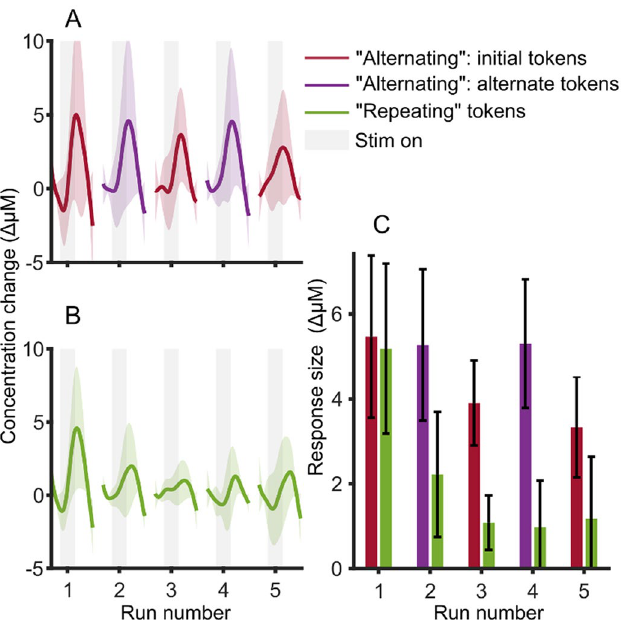
Figure 9. Comparison of responses to two sound presentation strategies. ( A ) Shows the “alternating” protocol, where two speech token pairs are presented in alternating runs. ( B ) Shows the “repeating” protocol, where the same speech token pair was repeated in five sequential runs. Shaded error bars show one standard deviation across participants. ( C ) Shows the calculated response sizes for both protocols as bar plots, with error bars showing one standard error of the mean; test statistics were calculated with these response